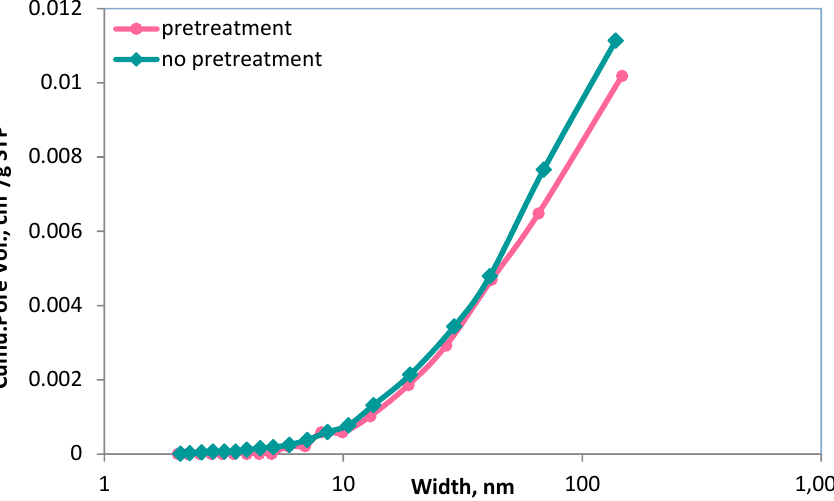
Figure 8. BJH (Barrett, Joyner, and Halenda) adsorption cumulative pore volume concerning the influence of pretreatment on the basis of the initial mixture of 66.7% Ni(NO 3 ) 2 , 33.3% glycine, and 75 mL H 2 O.